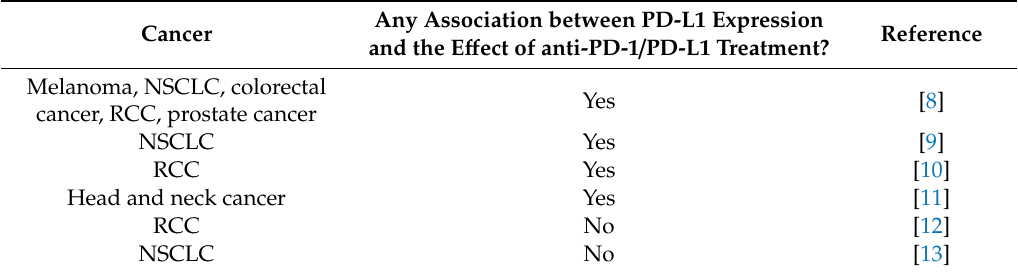
Table 1. Association between PD-L1 expression and the e ff ect of anti-PD-1 / PD-L1